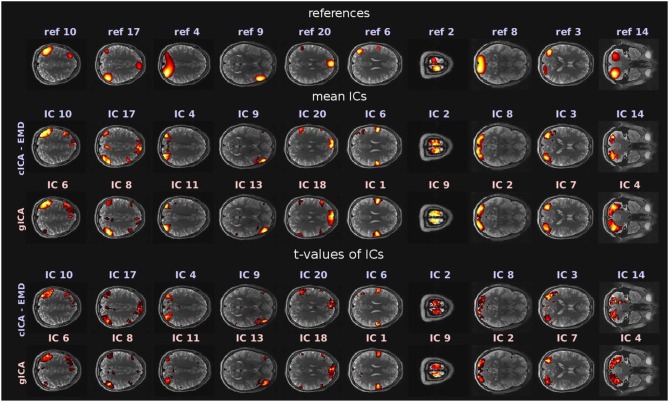
RSNs obtained by the two different approaches. The first row shows the references used for cICA, while the second row exhibits mean ICs, averaged over the subject cohort and computed with the newly proposed cICA-EMD method. These ICs are contrasted in the third row with mean ICs obtained by gICA. In the fourth and fifth row of this figure, t-values of the RSNs can be found. All depicted slices were chosen such that they intersect the peak activation voxel of the corresponding ICs obtained by gICA. For visualization purposes, the activations of the networks shown in the first three rows are normalized to zero mean and unit variance. Furthermore, in accordance with common usage, the voxel intensities Î(r) were thresholded by Î(r) > 2, and in the sixth and ninth column, the threshold was adjusted to Î(r) > 1.5 for better recognizability of the networks. The color range of the heatmap was adjusted to the largest intensity value in every pictured slice.